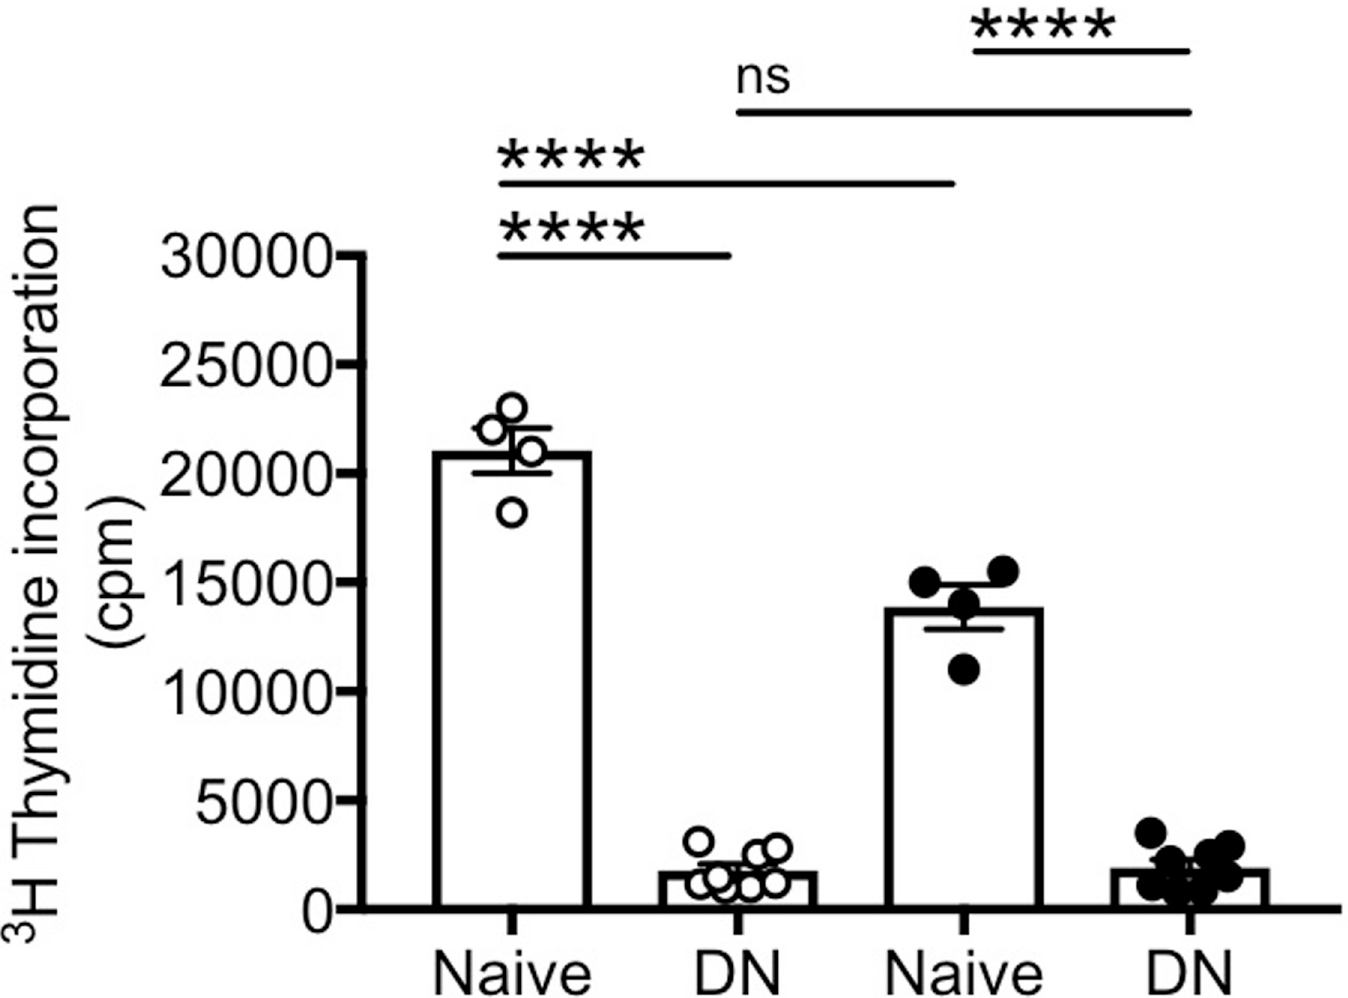
Fig 1. DN B cells do not proliferate. Na ï ve and DN B cells were sorted from the peripheral blood of 4 young (white symbols) and 8 elderly (black symbols) individuals. Sorted cells were stimulated with CpG and anti-Ig antibodies, together with IL-4. Proliferation of sorted B cell subsets was measured after 2 day stimulation by 3 H-Thymidine incorporation. Mean comparisons between groups were performed by one-way ANOVA. ���� p < 0.0001, ns: not significant.